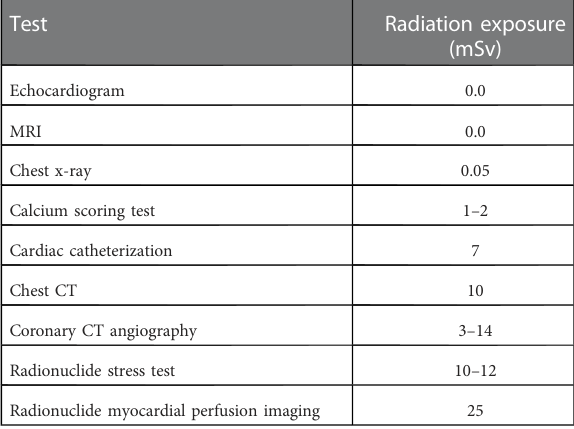
TABLE 1 Scanning technologies and associated ionizing radiation measured in millisieverts